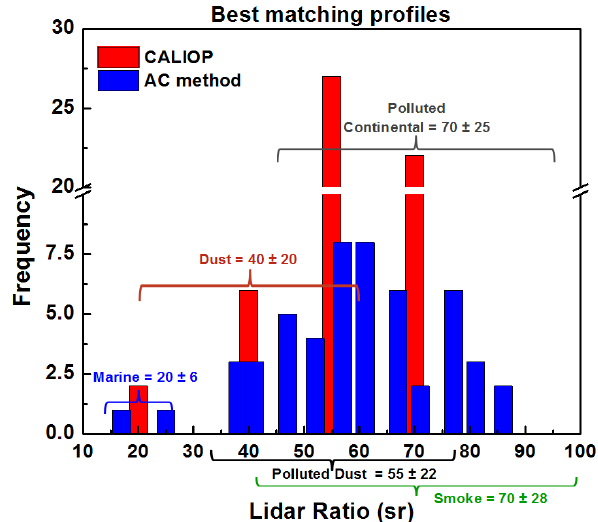
Fig. 5. Lidar ratio occurrence frequencies reported in the CALIPSO data products (red) and those derived using the AC model (blue). The natural variability ascribed to selected CALIOP aerosol models is shown by the ranges given along the lidar ratio axis. Lidar ratios derived by the AC model are seen to fall entirely within the range spanned by the CALIOP models.